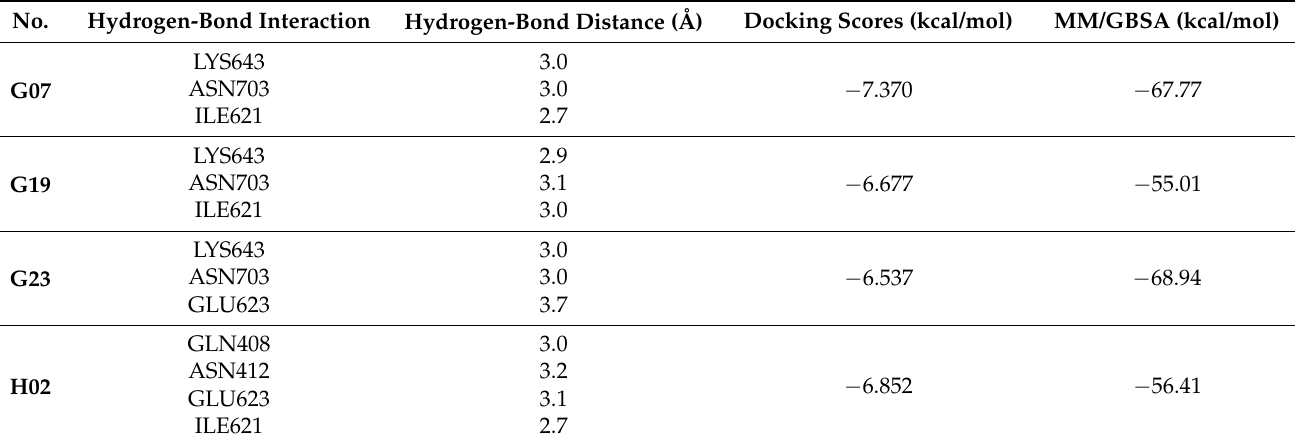
Table 3. Hydrogen-bond interactions of G07 , G19 , G23 and H02 with PA − PB1 endonuclease protein (PDB ID: